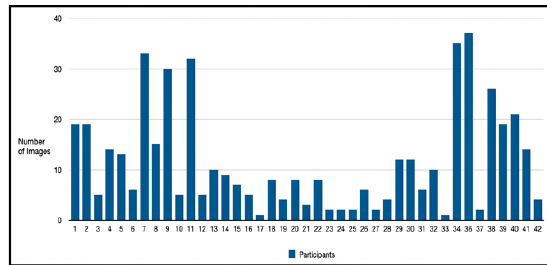
Figure 10. Number of images uploaded by user.